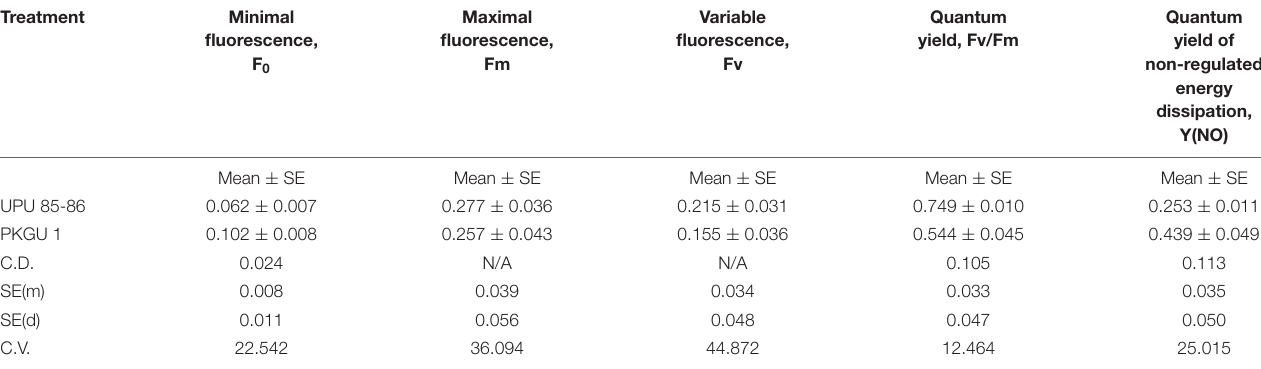
TABLE 11 | Fluorescence parameters to differentiate two contrasting heat tolerant and sensitive urdbean genotypes grown at 42/25 ◦ C max/min temperature.